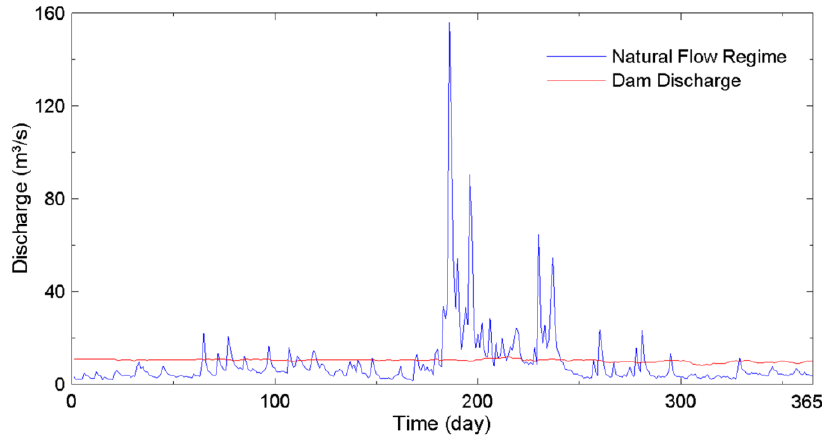
Figure 5. The natural flow regime and dam discharge.